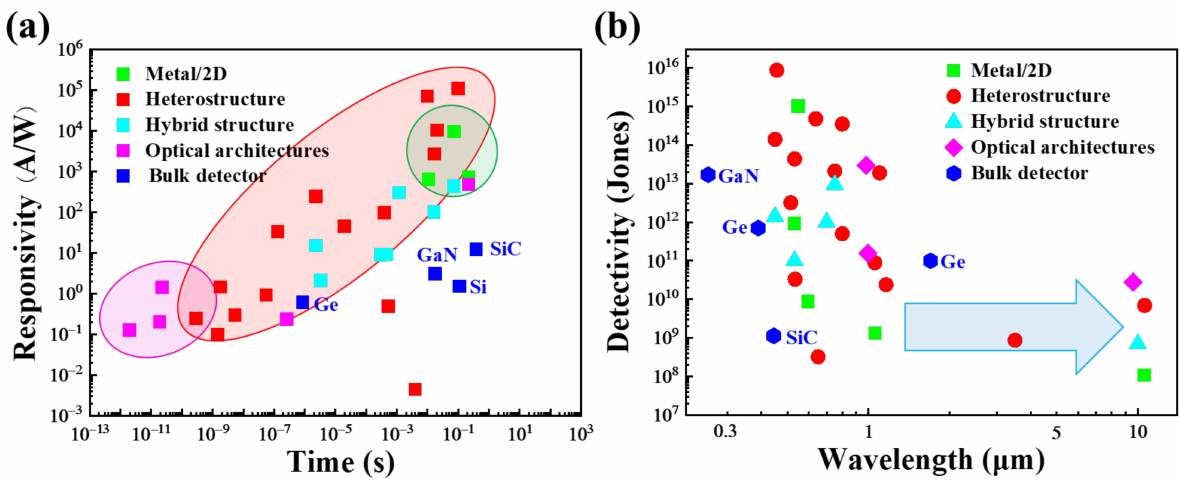
Figure 7. ( a ) Comparison of the responsivity and response time of 2D material detectors. ( b ) Specific detectivity versus response wavelength in different structures